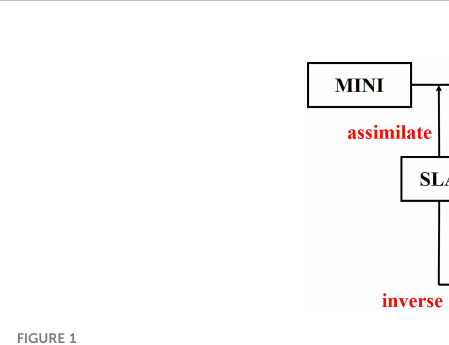
FIGURE 1 The diagrams of the